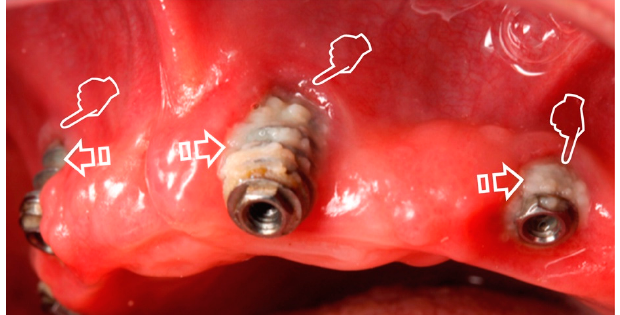
Figure 2. Gingival recession (pointers) caused by peri-implantitis with plaque deposits (arrows) on the implant surface. implant